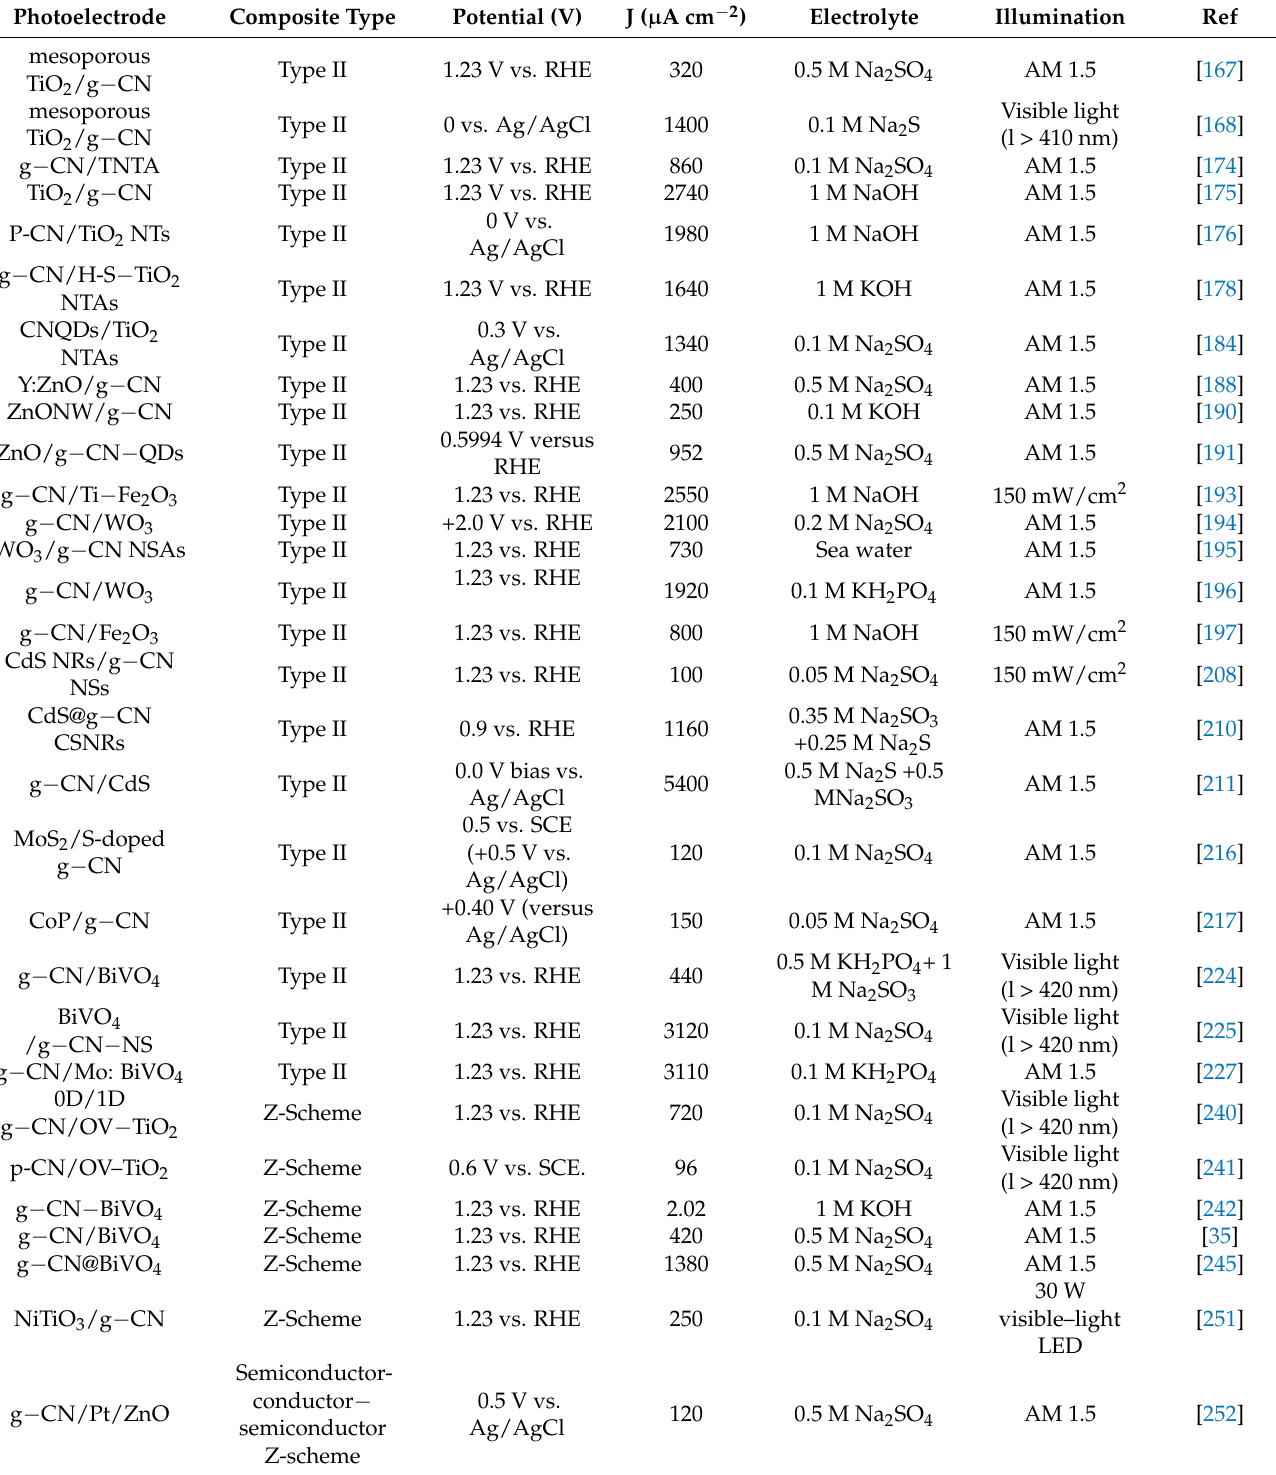
Table 4. Comparison of g − CN-based heterojunction photoelectrodes for PEC